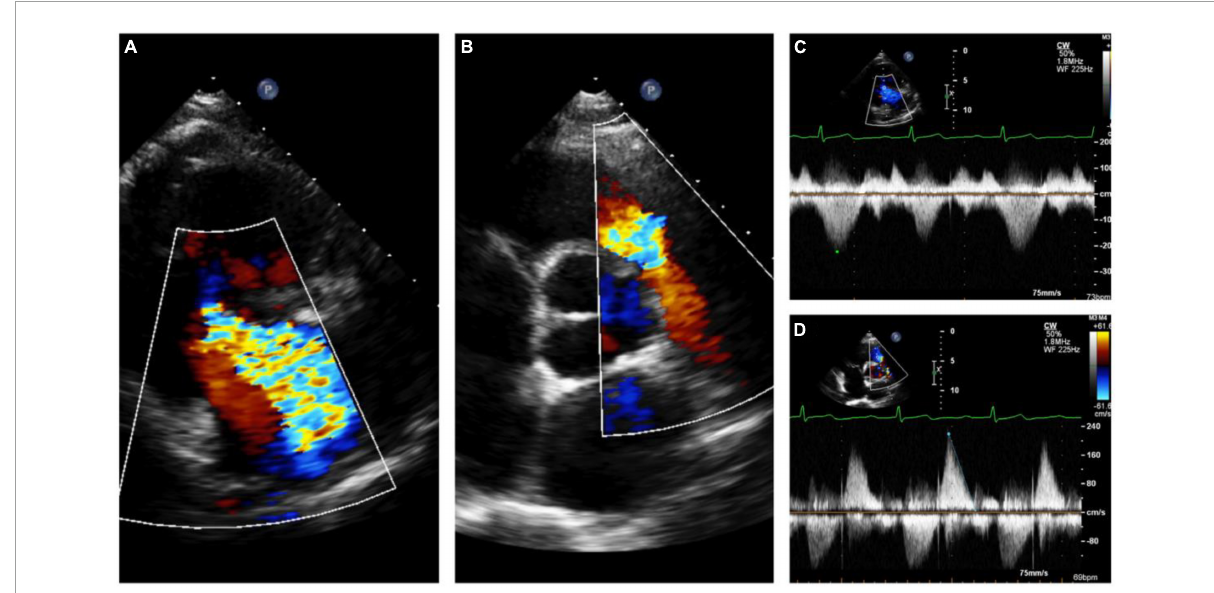
FIGURE6 Echocardiography monitoring in carcinoid heart disease (CnHD): Pre-surgical baseline echo. Severe tricuspid regurgitation (A) with pulmonary valve stenosis (B) with corresponding continuous wave Doppler (C, D) .